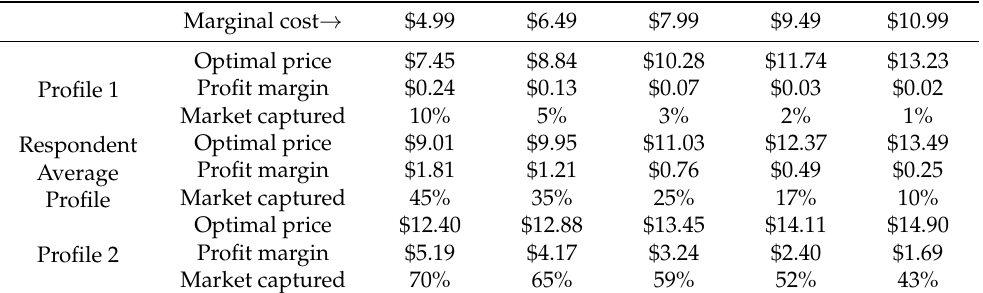
Table 5. Optimal prices, profit margins, and market captured given marginal costs across three market